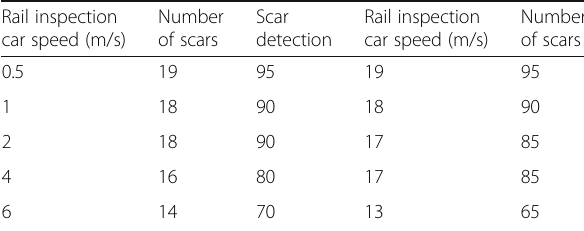
Table 3 Rail surface defect detection results Rail inspection car speed